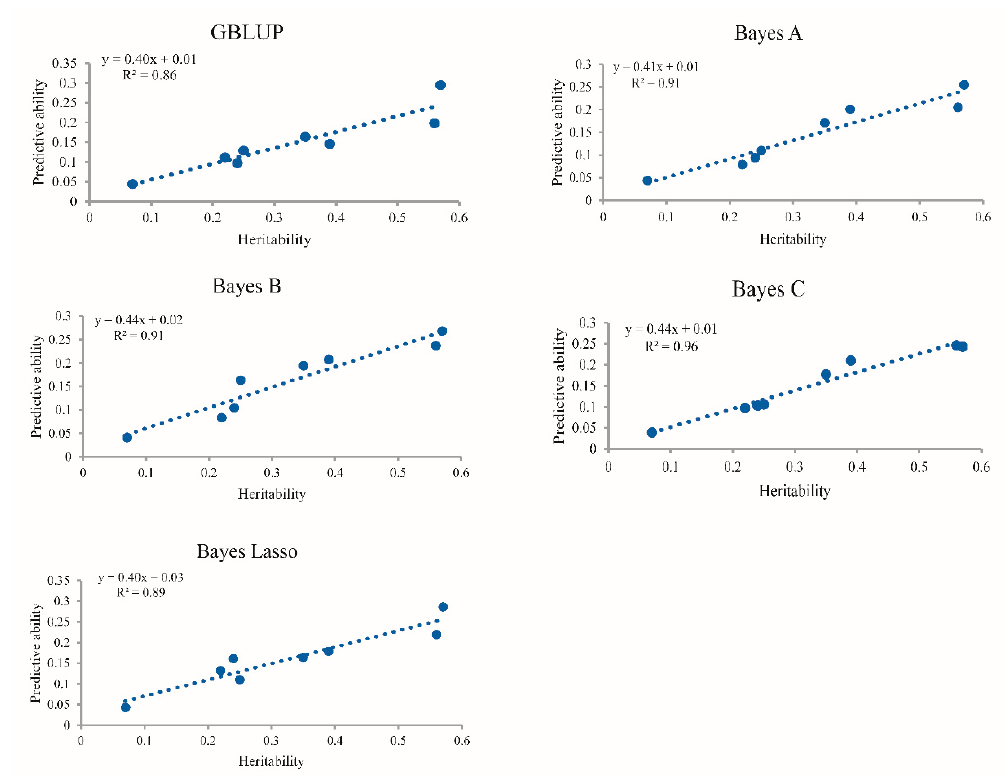
Figure 2. Regression of predictive ability on heritability for early growth traits using five approaches. GBLUP: genomic best linear unbiased prediction.